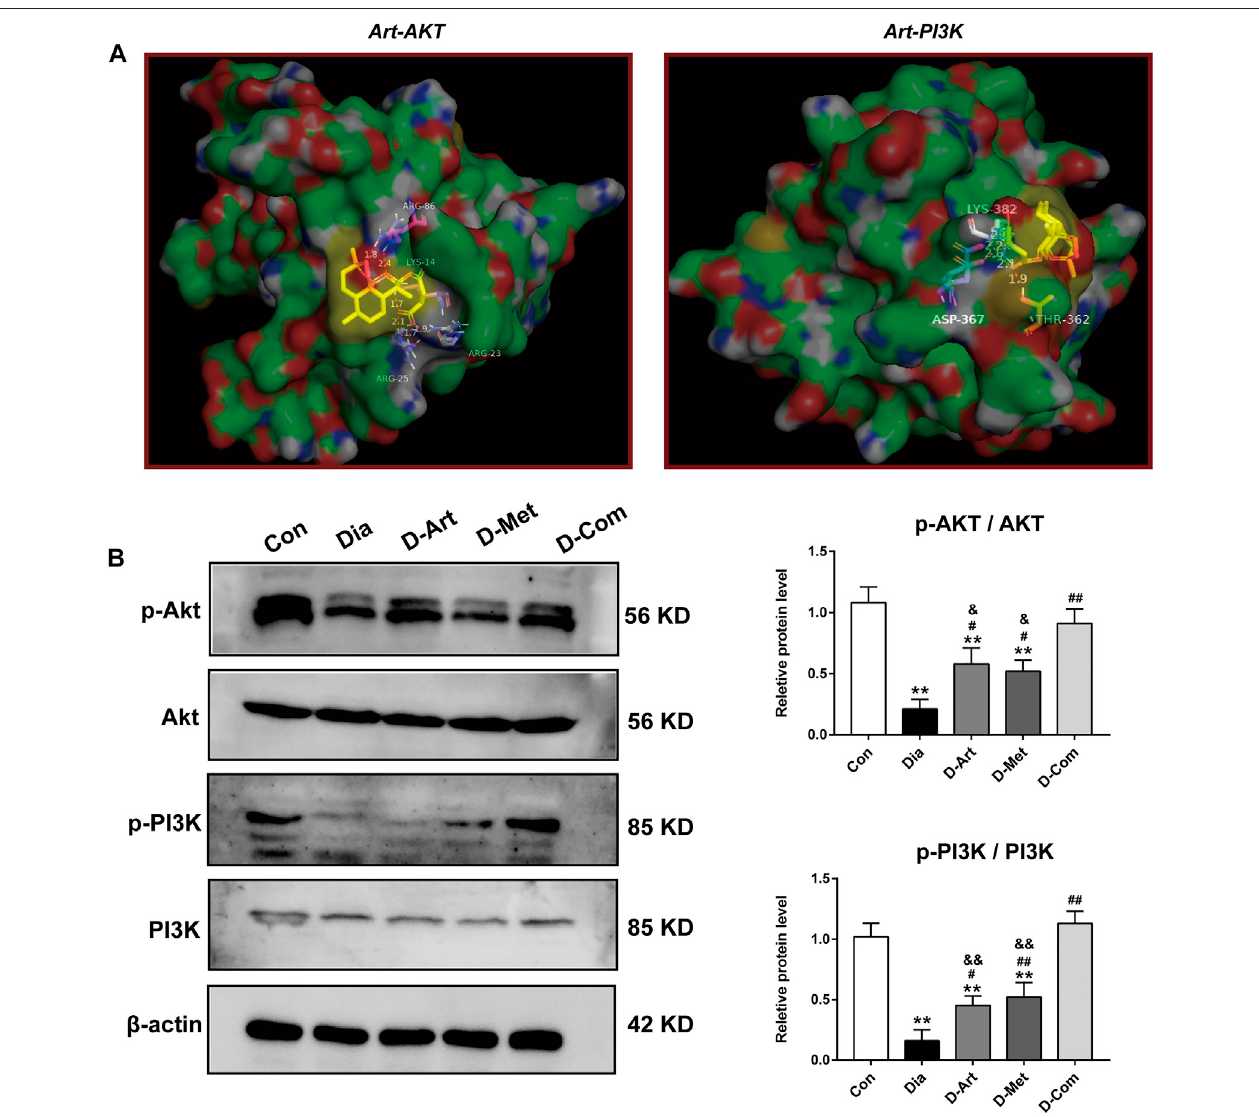
FIGURE 7 | ART or Met alone and ART/Met combination activate PI3K/AKT pathway in SMGs of the T2DM rats. (A) Molecular docking of ART to Akt and PI3K protein. (B) Western blot analysis of p-AKT/AKT and p-PI3K/PI3K (5 rats per group). Protein expression is normalized to β -actin. Data are expressed as the mean ± SD. ** p < 0.01 versus Con group; # p < 0.05 and ## p < 0.01 versus Dia group; & p < 0.05 and && p < 0.01 versus D-Com group. Con, Normal control group; Dia, Untreated diabetic group; D-Art, ART-treated diabetic group; D-Met, Met-treated diabetic group; D-Com, ART/Met co-treated diabetic